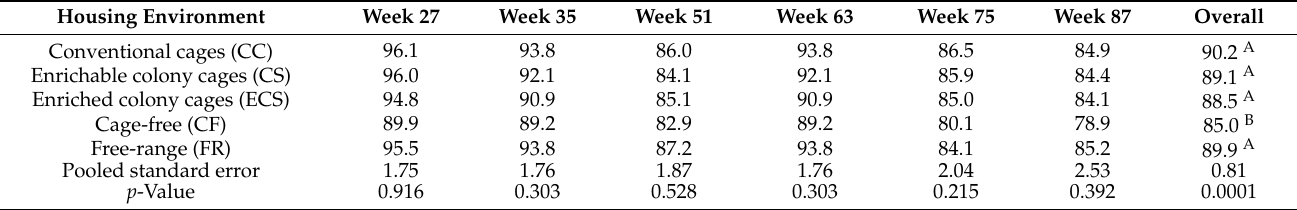
Table 6. The effect of housing environment on Haugh Unit of brown egg layers by week and